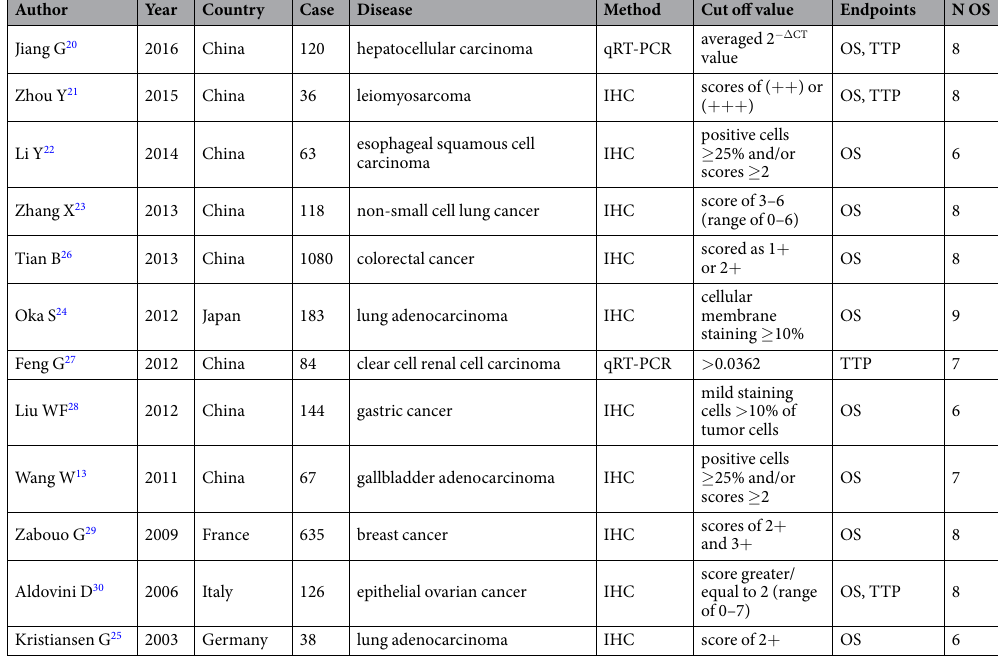
Table 1. Characteristics of studies included in the meta-analysis. ICH: Immunohistochemistry; qRT-PCR: quantitative Real-time polymerase chain